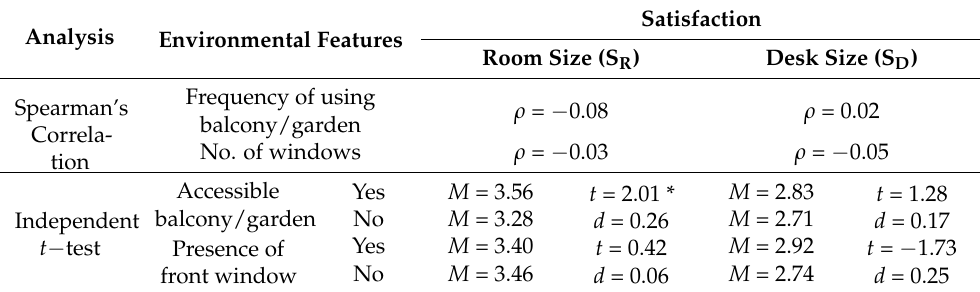
Table 5. Relationships between openness-related environmental features and satisfaction with home workspace